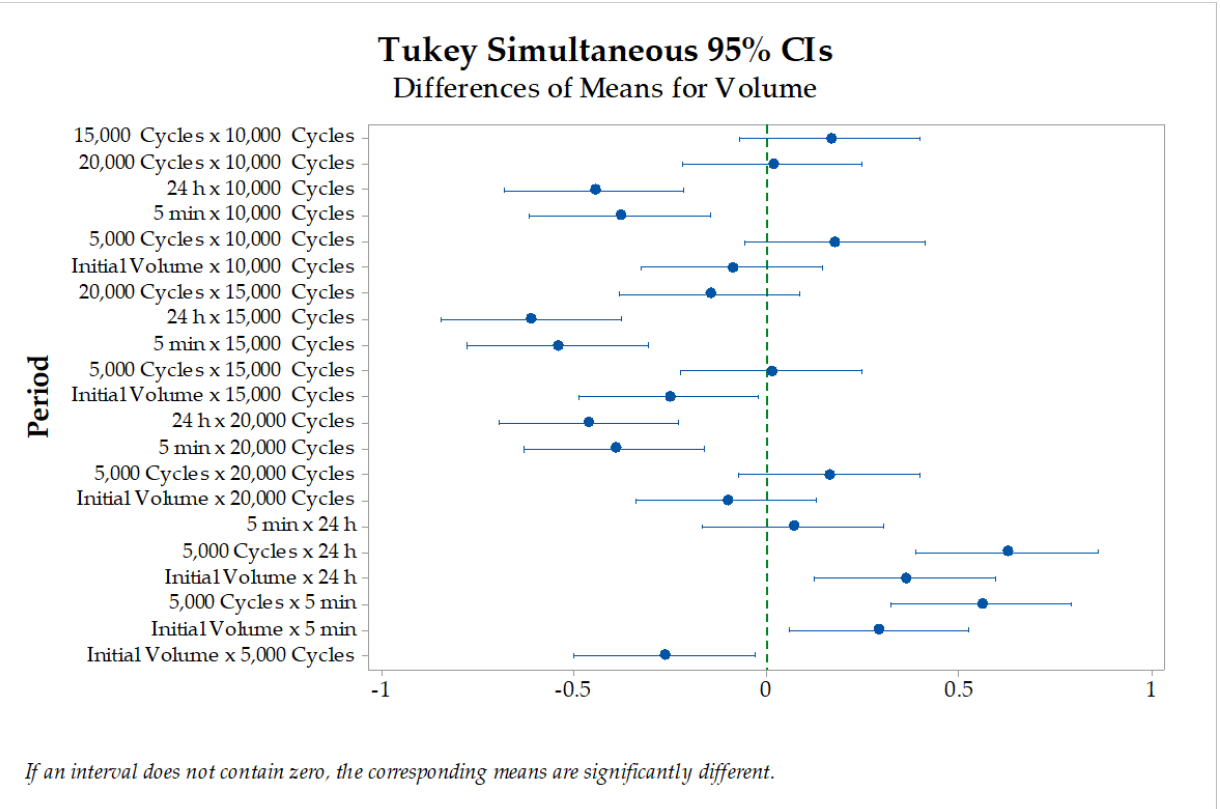
Figure 5. Resin composite hygroscopic expansion trend in function of the aging process progression (5 min, 24 h, 5000 to 20,000 thermal cycles.